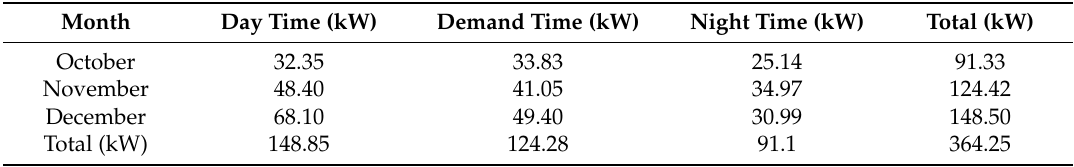
Table 5. The amount of power consumption according to energy tariff.